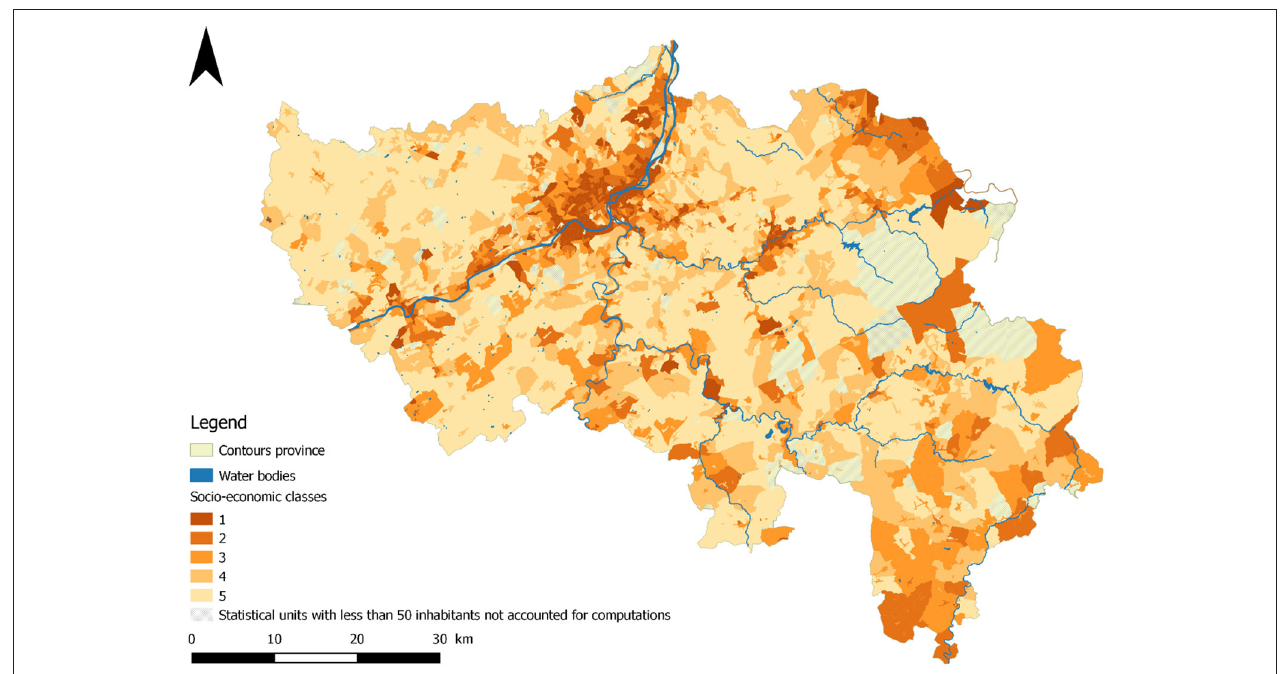
FIGURE 2 | Index of social disparity (ISD) in the Province of Liege.